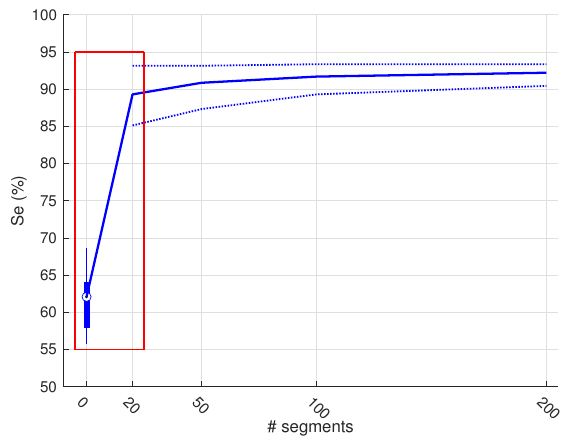
Figure 9. The Se of the CC base classifier when applied on the HH dataset. The full line corresponds to the median values and the dotted lines indicate the interquartile ranges. We used a different graphical representation for the results of the base classifiers at zero, as these results originate from only 25 folds, compared to the 250 folds of the transfer learning approach. A strong increase could already be observed after including only 20